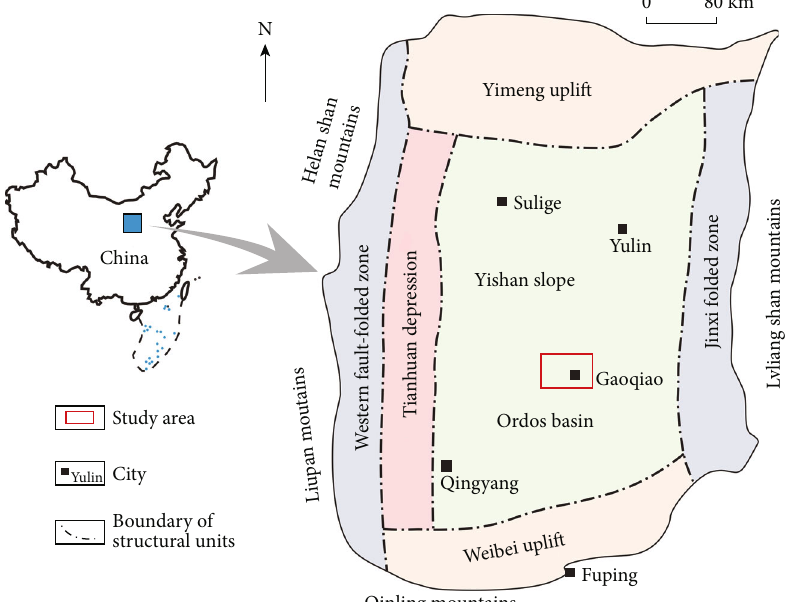
Figure 1: Location of the study area and tectonic units of the Ordos